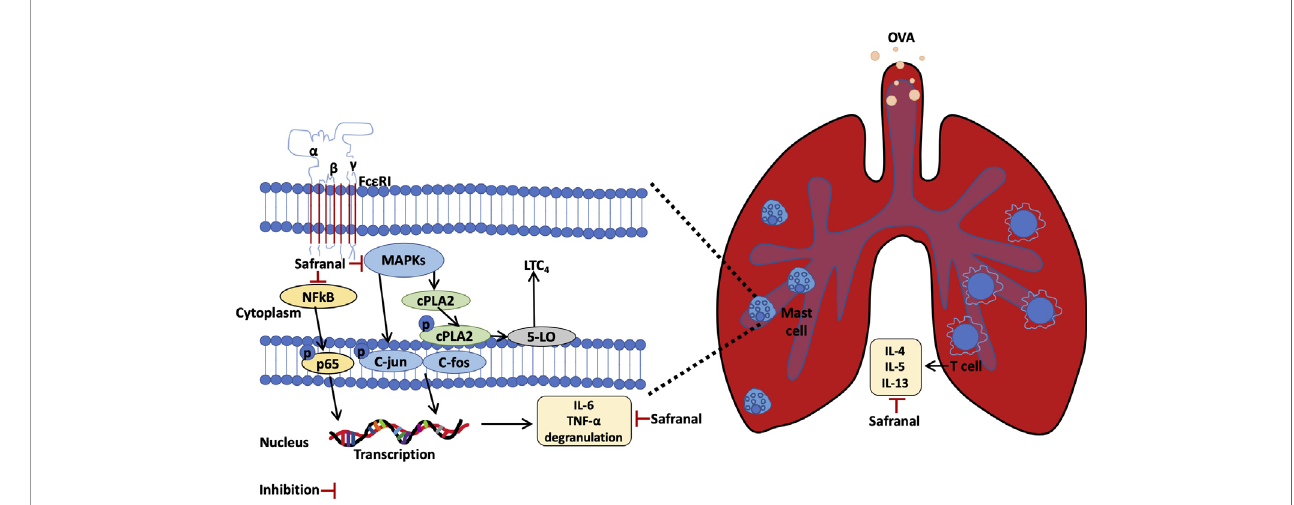
FIGURE 10 | Safranal alleviated OVA-induced asthma model and inhibits mast cell